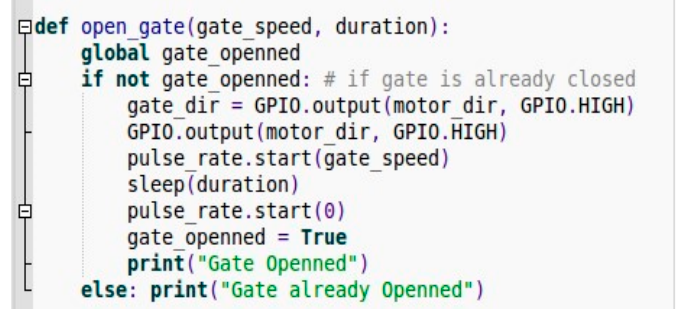
Figure 12. Code Excerpts: controlling motor to open the gate.